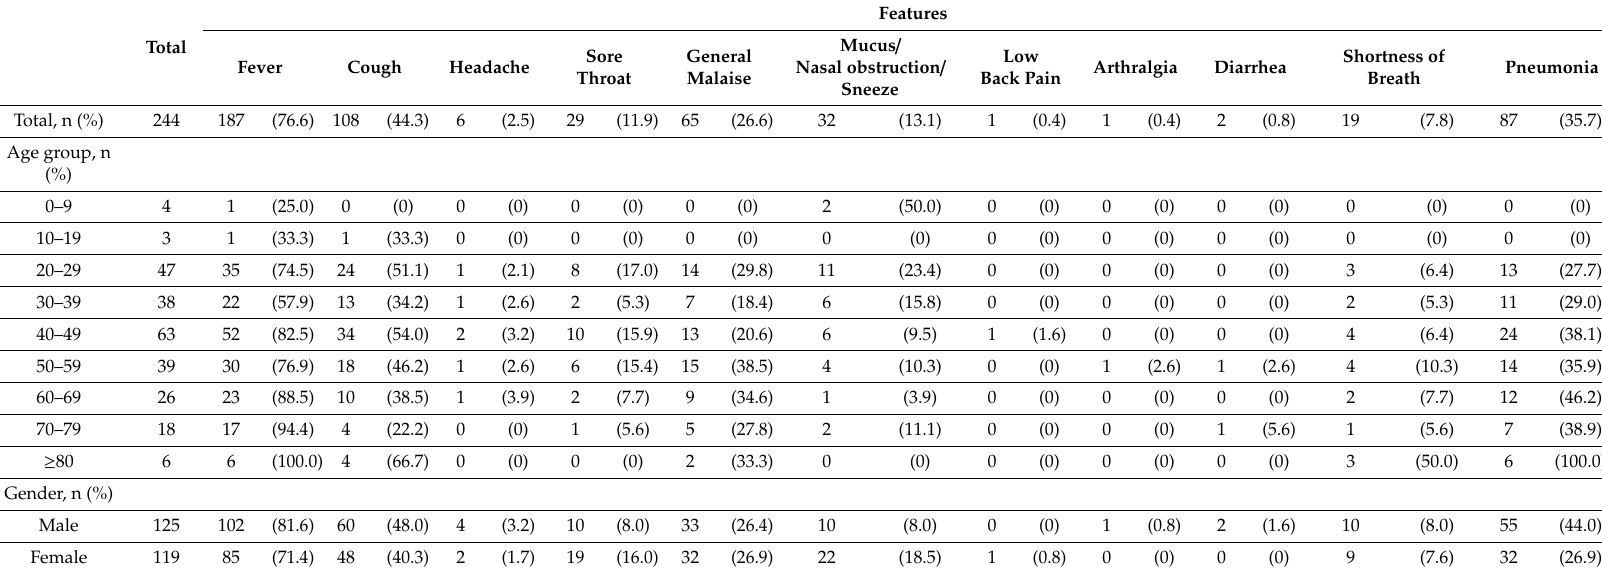
Table 1. Distribution of features according to age group and